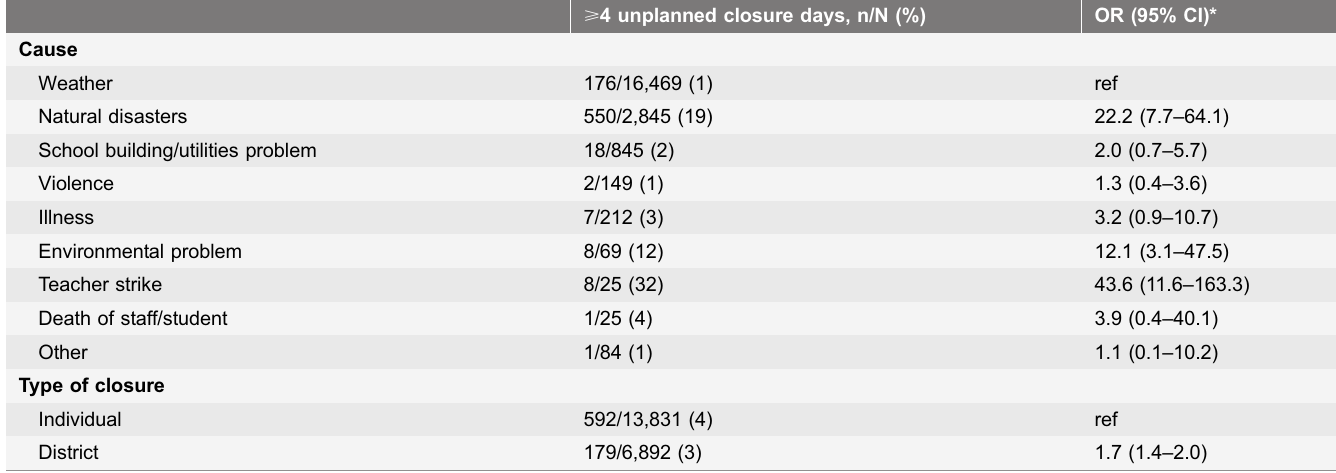
Table 3. Selected characteristics of school closure events and association with > 4 unplanned closure days — United States,